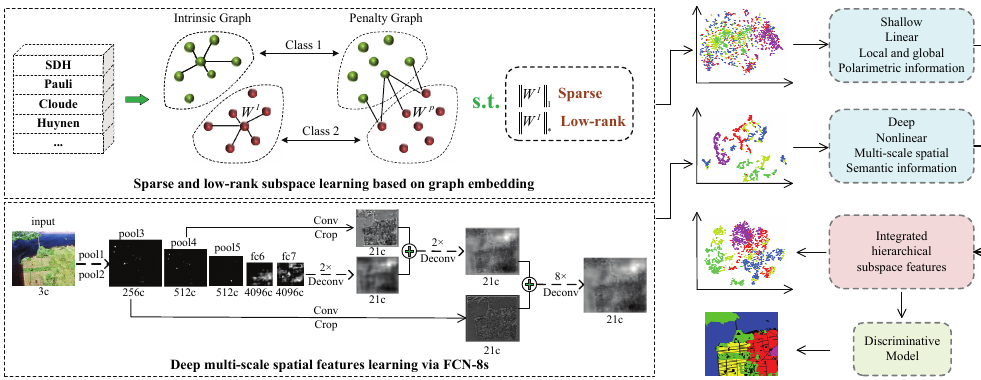
Figure 1. The framework of the proposed methods. Upper left: learn sparse and low-rank subspace representations of high-dimensional polarimetric data. Lower left: learn deep multi-scale spatial features via FCN-8s. Middle column: visualizations of subspace features in 2D space and classification map. Right column: integrate hierarchical subspace features for classification combined with a discriminative